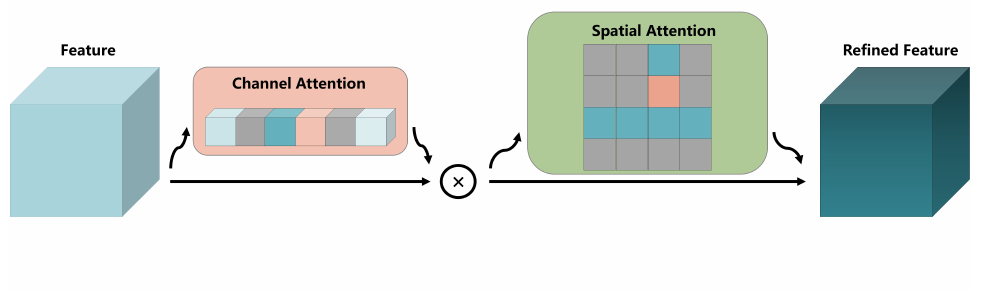
Figure 5. Architecture of the combined